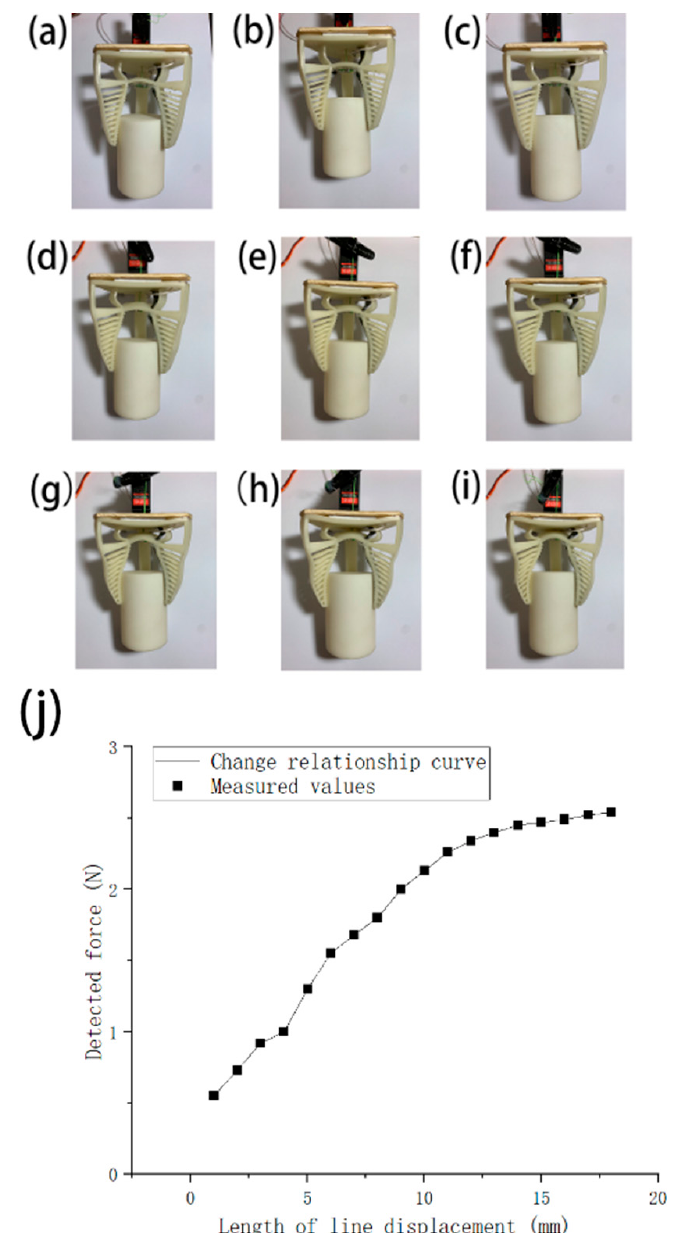
Figure 9. Force measurement when grasping an object. ( a – i ) are snapshots of grasping a 3D-printed cylinder. ( j ) shows a graph of the relationship between the change in force during grasping of an object and the change in displacement of the pulling wire.